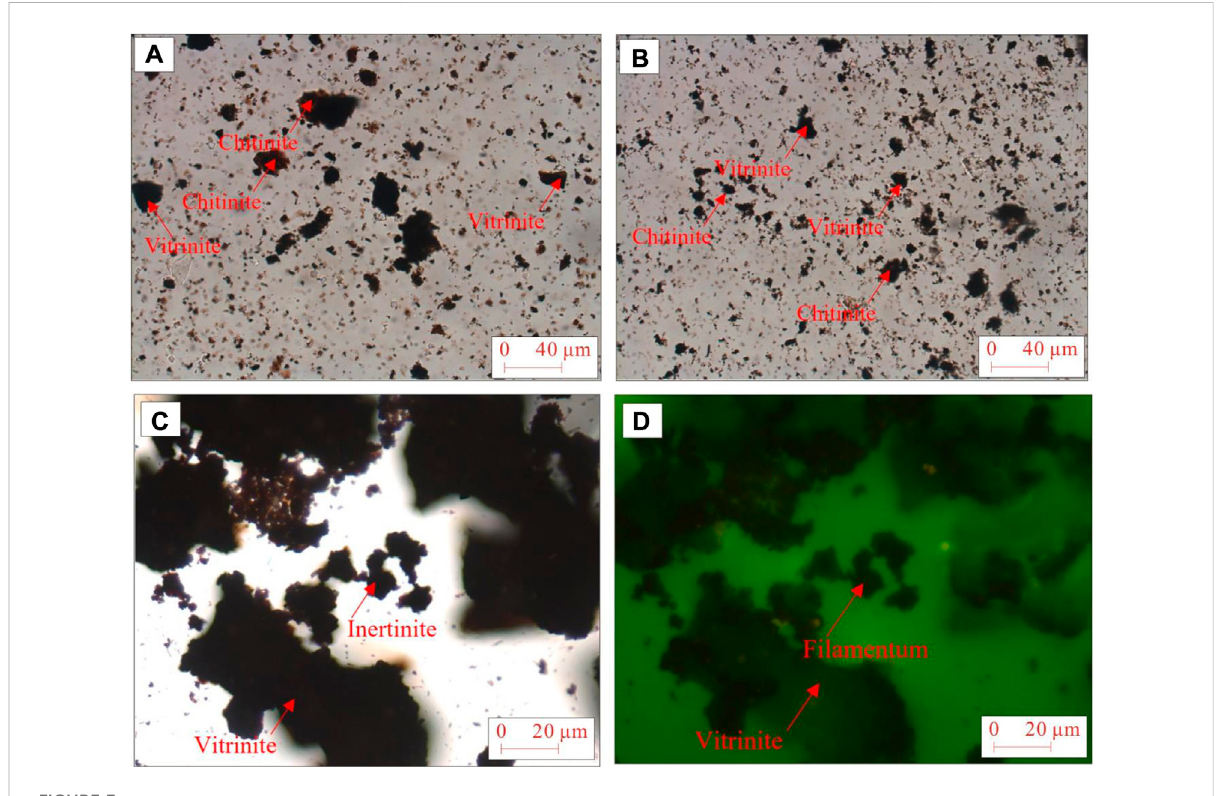
FIGURE 3 MicrocomponentsofkerogeninsourcerocksofXujiaheFormation. (A) JinhePro fi le,Xu1Member; (B) ZhanggonglingPro fi le,Xu5Member; (C) and (D) Well Jin 31, 3,017.92